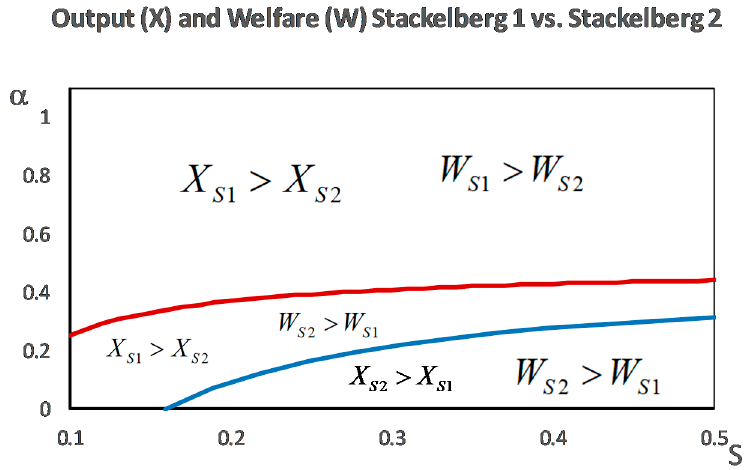
Figure 3. Output and welfare comparison between Stackelberg 1 and 2.